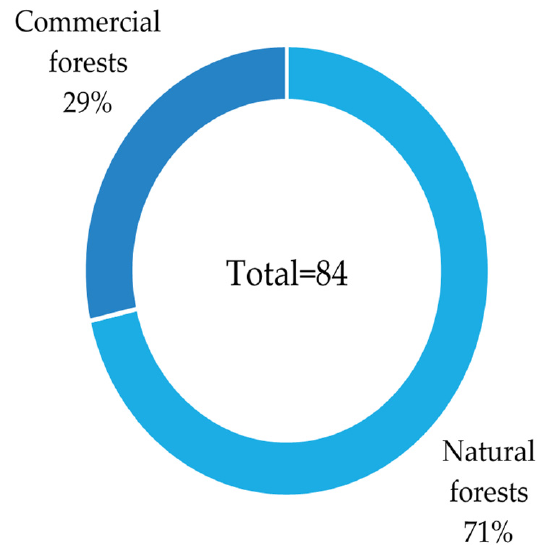
Figure 2. Number of LAI studies for natural forests and commercial forests.